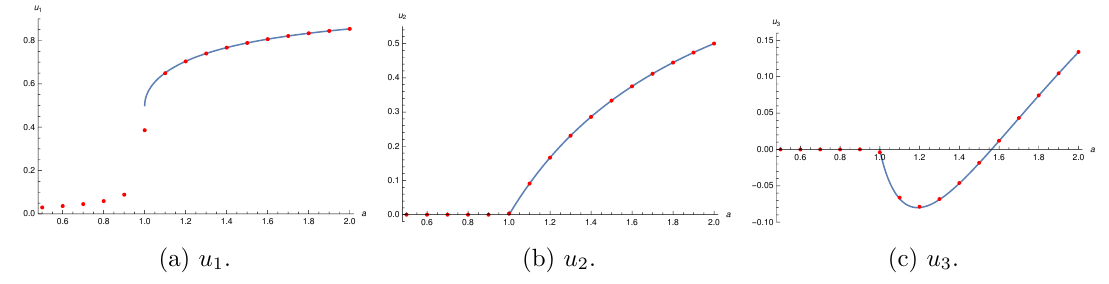
h Tr U k i a in the N